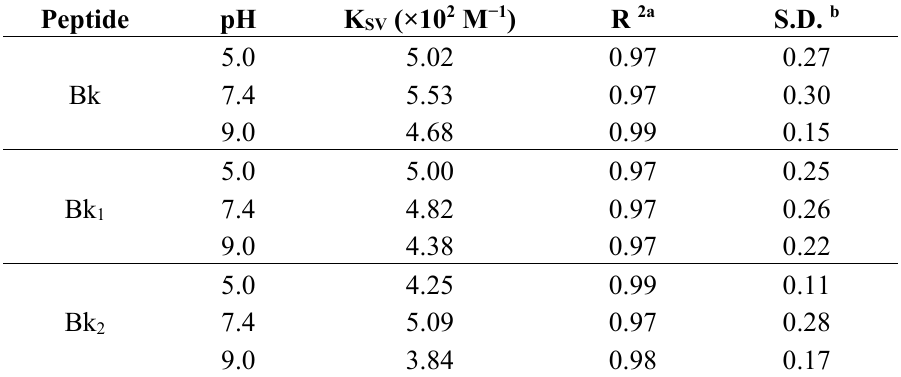
Table 2. Stern-Volmer quenching constants (K SV ) of the BTCI in complex with Bk, Bk 1 and Bk 2 at different pHs.